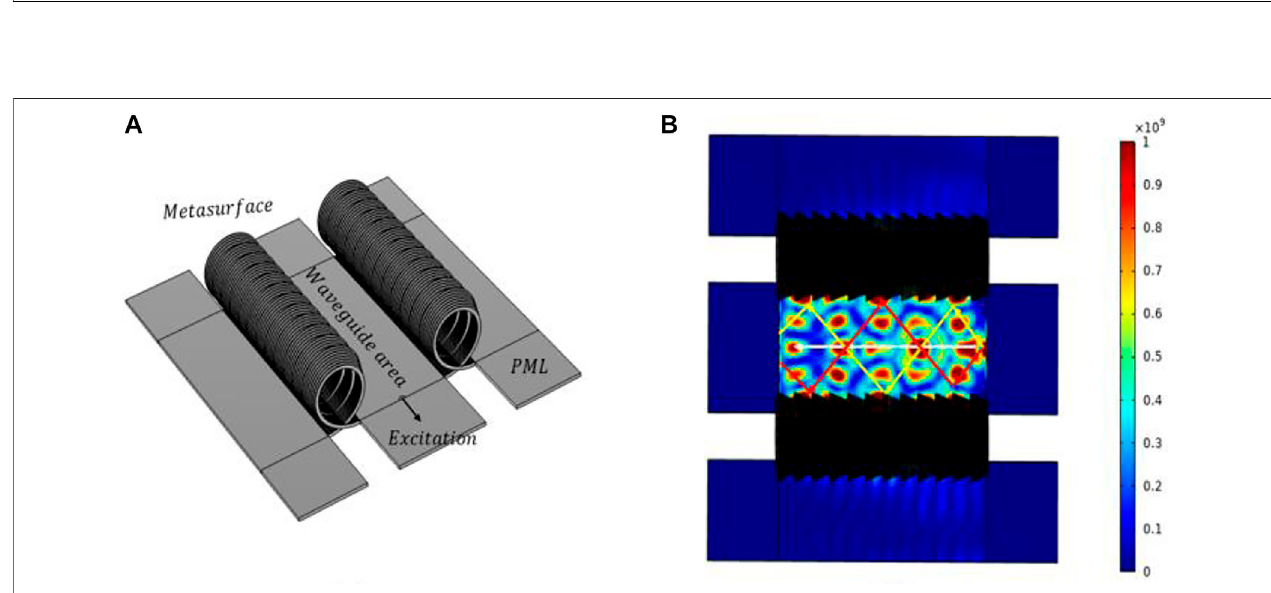
FIGURE 15 | (A) Schematic diagram of metasurface waveguide structure; (B) energy density diagram of Lamb wave propagating in the waveguide region.